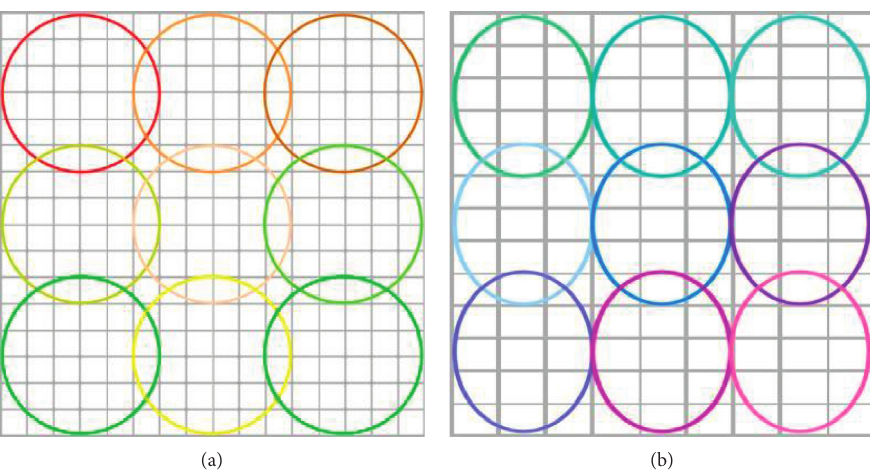
Figure 4: Multiscale sampling with variable sampling size and stride. (a) 16 × 16 multiscale sampling. (b) 13 × 9 multiscale